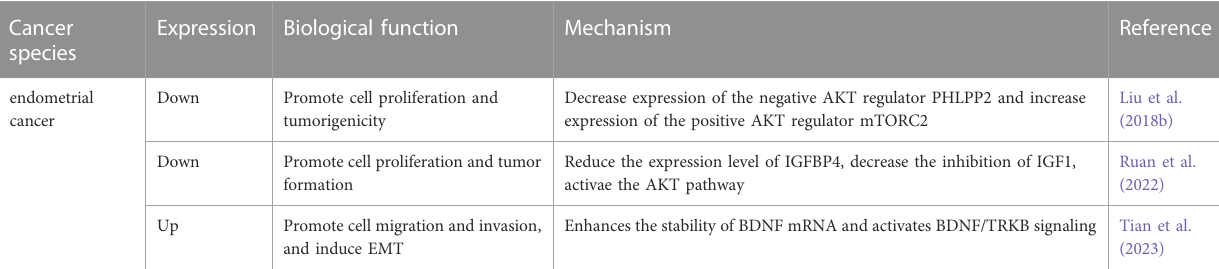
TABLE 3 The role of Mettl3 in endometrial